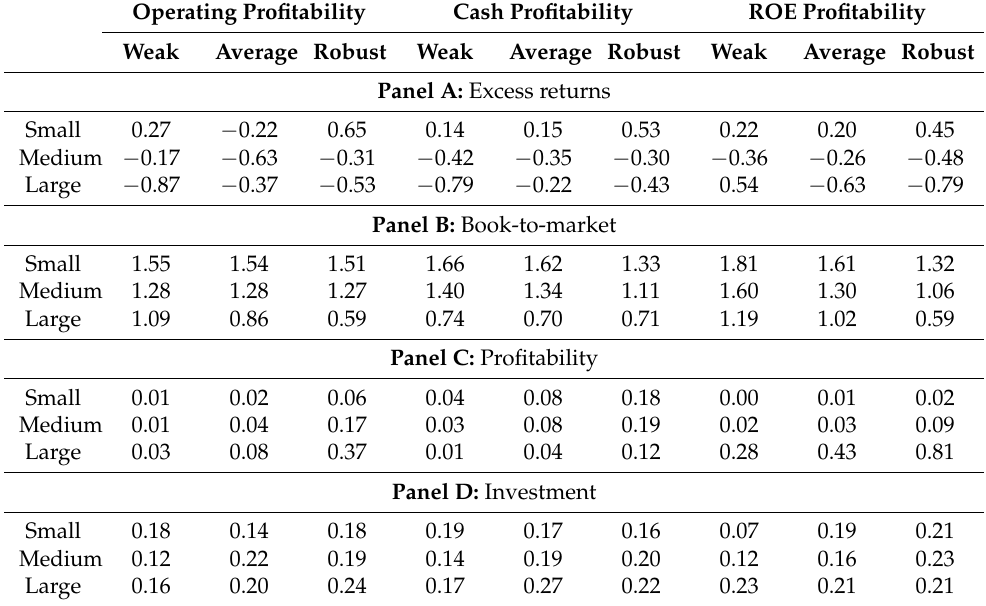
Table 7. Characteristics of portfolios sorted on a combination of size and operating profitability, cash profitability or return-on-equity (ROE) profitability. The table provides time-series averages of excess returns, book-to-market, profitability and investment ratios in July of year t to June of year t + 1 for portfolios formed in December of year t − 1 on the double sort of size and a combination of cash profitability (Ball et al. 2015; Fama and French 2018), ROE profitability (Hou et al. 2015, 2019) and operating profitability (from Table 4). The portfolio formation and book-to-market, profitability and investment ratios follow the Fama and French (2015) methodology. Each of the ratios for a portfolio in a given year is a value-weighted average of the ratios for the firms in the portfolios. Panel ( A ) provides time-series averages of the monthly returns in excess of Vietnam’s interbank offer rate (in percentages). Panels ( B – D ) show the book-to-market, profitability and investment times-series averages for a portfolio. Column Weak shows the characteristics of portfolios of stocks sorted by size (small, medium and large) and low profitability ratio. Column Average shows the characteristics of portfolios of stocks sorted by size (small, medium and large) and average profitability ratio. Column Robust shows characteristics of portfolios of stocks sorted by size (small, medium and large) and high profitability ratio. The sample is from September 2008 to July 2015.